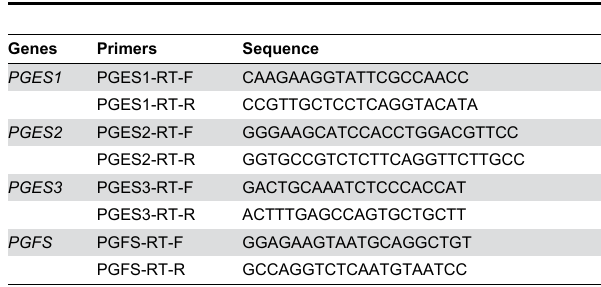
Table 3. Primer sequences used in quantitative real-time PCR